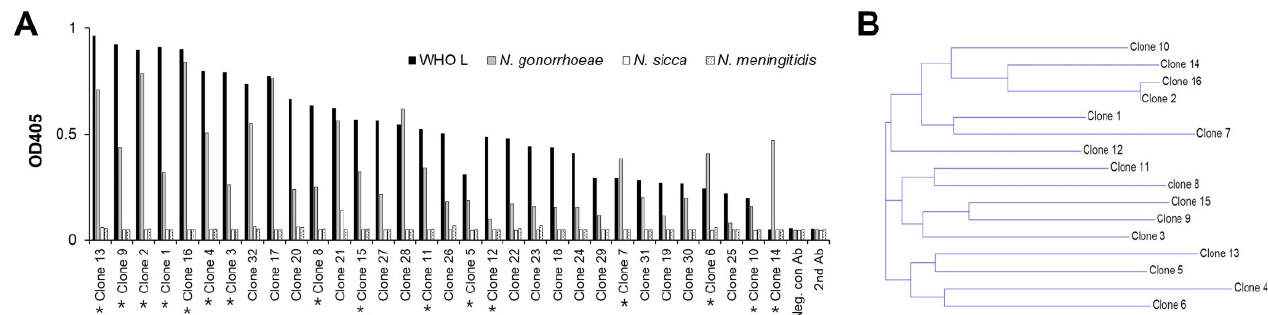
Figure 2. Identification of N. gonorrhoeae -specific scFv-phage clones. ( A ) The binding properties of randomly selected scFv-phage monoclonal antibodies to N. gonorrhoeae and WHO L ( N. gonorrhoeae reference strain) were measured via throughput phage ELISA. Any scFv-phage antibodies binding to N. sicca and N. meningitidis were considered non-specific N. gonorrhoeae antibodies. Myo22 was used as the negative control for the scFv-phage. The unique anti- N. gonorrhoeae scFv-phage clones and secondary antibody (anti-M13-HRP) are indicated by a star (*) and 2nd Ab, respectively. ( B ) Phylogram tree for the comparison of scFv amino acid sequences in the 16 unique anti- N. gonorrhoeae scFv-phage clones. Phylogram trees were produced using the AlignX program, and the clone numbers are listed along the plot’s right side.